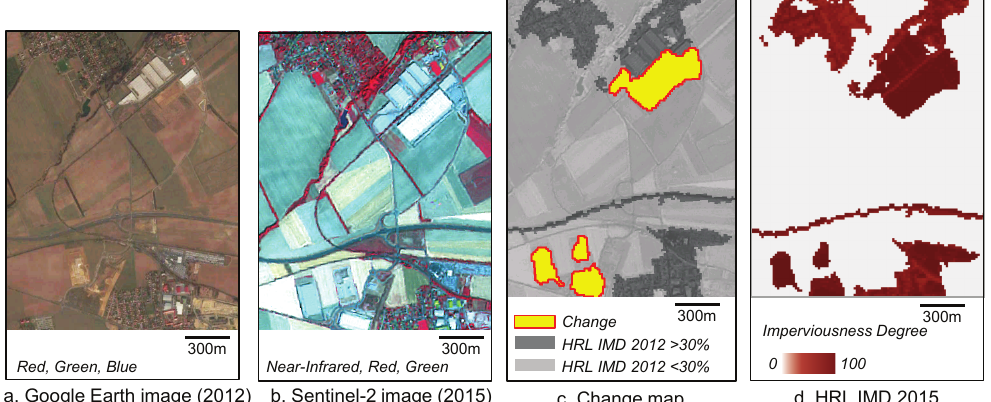
Figure 13. Detection of new commercial or industrial areas in Prague (yellow: changes; dark grey: HRL IMD 2012 >30%; light grey: HRL IMD 2012 <30%). ( a ) Google Earth image (2012); ( b ) Sentinel-2 image (2015); ( c ) Change map; ( d ) HRL IMD 2015.